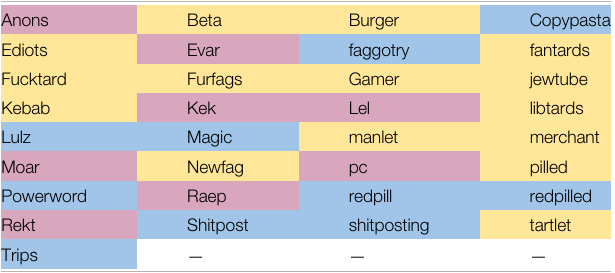
TABLE 2 | Words collected from the top 200 changing and new words on both 4chan/pol/and ED, after fi ltering for misspellings, proper names, duplicates, and othernoise.Non-representativeorder. Wordsprimarilycategorized as “ group terminology ” are marked in blue; “ ironic word play ” in mauve; “ re fl exive performativity ” in